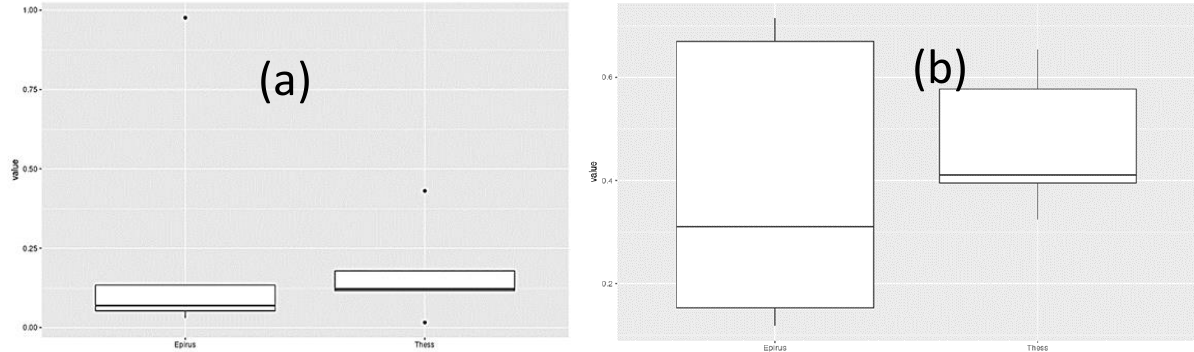
Figure 4. Boxplots of the divergences within the Epirus and Thessaly groups with respect to the median profile within each group. ( a ) all the species included in the analysis ( p = 0.841); ( b ) after the three major species were removed from the analysis ( p = 0.151).